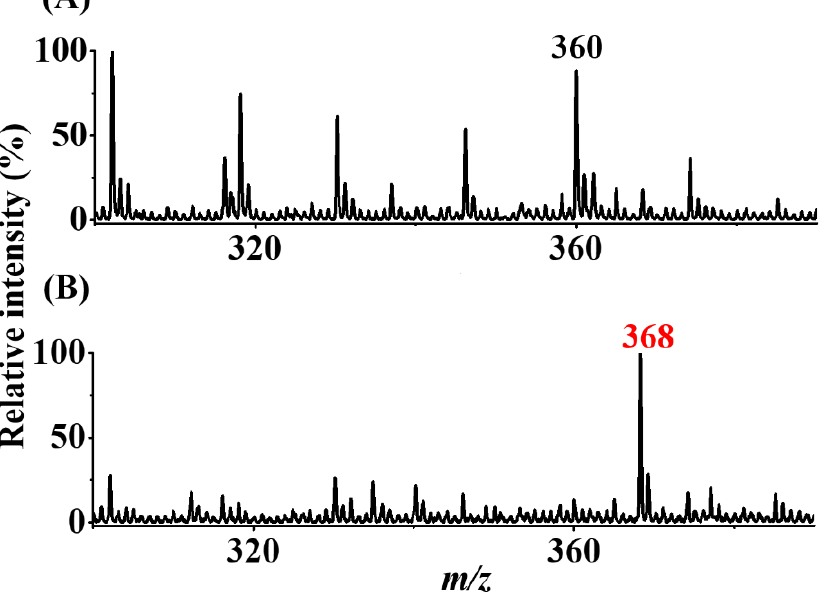
Figure 7. Real sample analysis. SPME-CFI mass spectra of the samples (7.5 mL) containing peanut extract ( A ) without and ( B ) with additional AFB1 (20 nM) obtained after enrichment. The elution solvent (10 μL) contained acetonitrile/ethanol/deionized water (2:2:1, v / v / v ) with the addition of butylamine (1 μM).